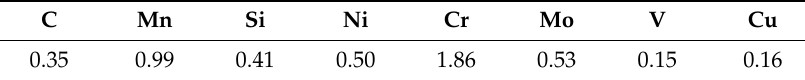
Table 1. Chemical composition of the investigated steel